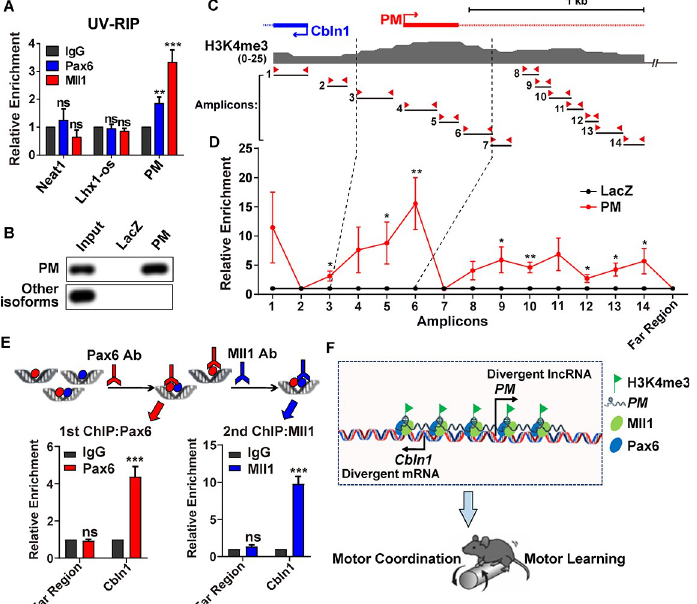
Fig 6. In vivo association of lncRNA-PM and Pax6/Mll1 complex with Cbln1 . (A) UV-RIP assay showed PM :Pax6 and PM :Mll1 interactions in mouse cerebellum. Neat1 and lncRNA-lhx1os : negative controls. Data are shown as means ± SEMs, n = 3. (B) RT-qPCR detection following PM RNA pull-down using cerebellum tissue. PM: PM probes; LacZ: control probes. (C) Illustration of H3K4me3 signature on the upstream regulatory region of Cbln1 locus from +300 to − 2,000 base pair based on ENCODE data in mouse cerebellum. The 14 pairs of amplicons are indicated. (D) ChIRP-qPCR showed occupancy of PM to the regions amplified by the indicated 14 amplicons and a control region that is 85 kb upstream of Cbln1 transcription start site (Far Region). Data are shown as means ± SEMs, n = 3. (E) Re- ChIP of Pax6 and Mll1. Top: illustrated flowchart of double ChIP experiment. Bottom left: recruitments of Pax6 or IgG to Cbln1 or the negative control region (Far Region) after first ChIP in mouse cerebellum. Bottom right: recruitments of Mll1 or IgG to Cbln1 or Far Region after second ChIP in mouse cerebellum. Data are shown as means ± SEMs, n = 3. (F) Model: LncRNA - PM mediates the transcriptional activation of Cbln1 through Pax6/Mll1-mediated H3K4me3 and maintains mouse motor coordination and motor learning. All the data of this figure can be found in the S1 and S2 Data files. � P < 0.05, �� P < 0.01, and ��� P < 0.001. Cbln1 , Cerebellin-1 ; ChIP, chromatin immunoprecipitation; ChIRP, chromatin isolation by RNA purification; IgG, immunoglobulin G; lncRNA-PM , lncRNA-Promoting Methylation ; ns, no significance; qPCR, quantitative PCR; Re-ChIP, Re-chromatin immunoprecipitation; RT-qPCR, reverse transcription-quantitative PCR; UV-RIP, UV-RNA